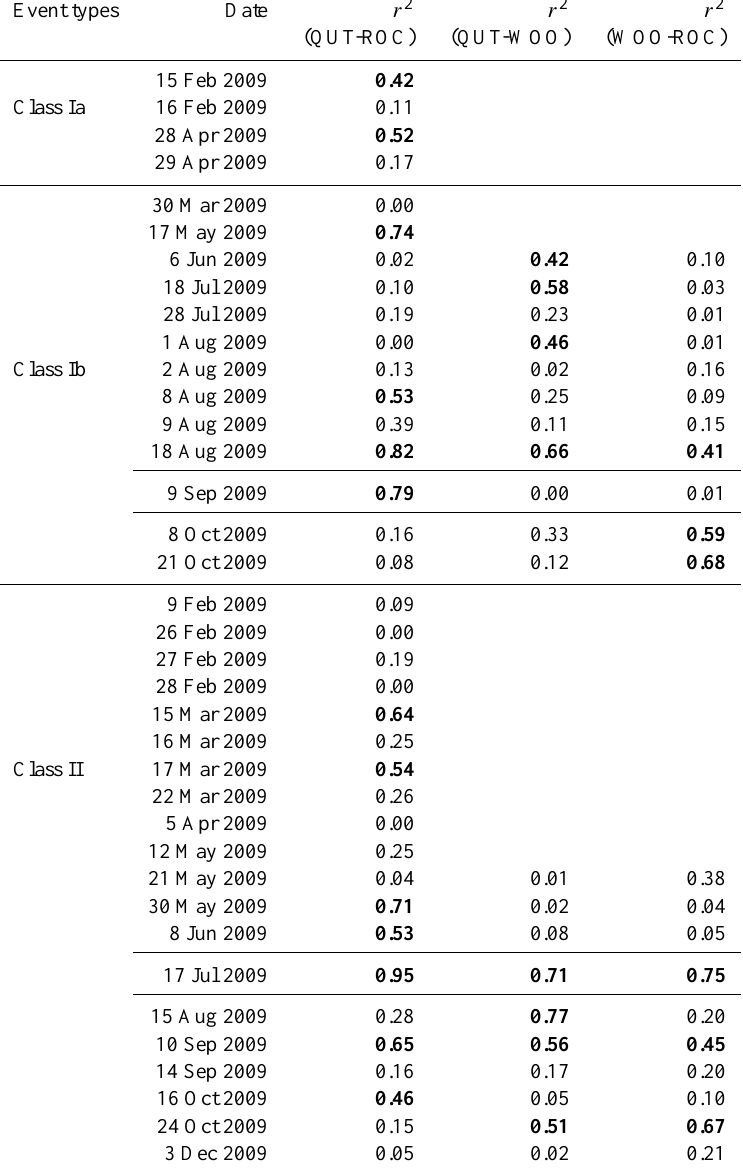
Table 2. The r 2 values for PNC at QUT, WOO and ROC during nucleation growth events ( r 2 values > 0 . 4 are bolded). Nucleation events were classified into Class Ia/b where the particle growth rate can be determined and Class II where the banana shape still observable, but the data fluctuates to such an extent that formation rate calculation is impractical. More detailed explanation of class type can be found in Cheung et al. (2011).